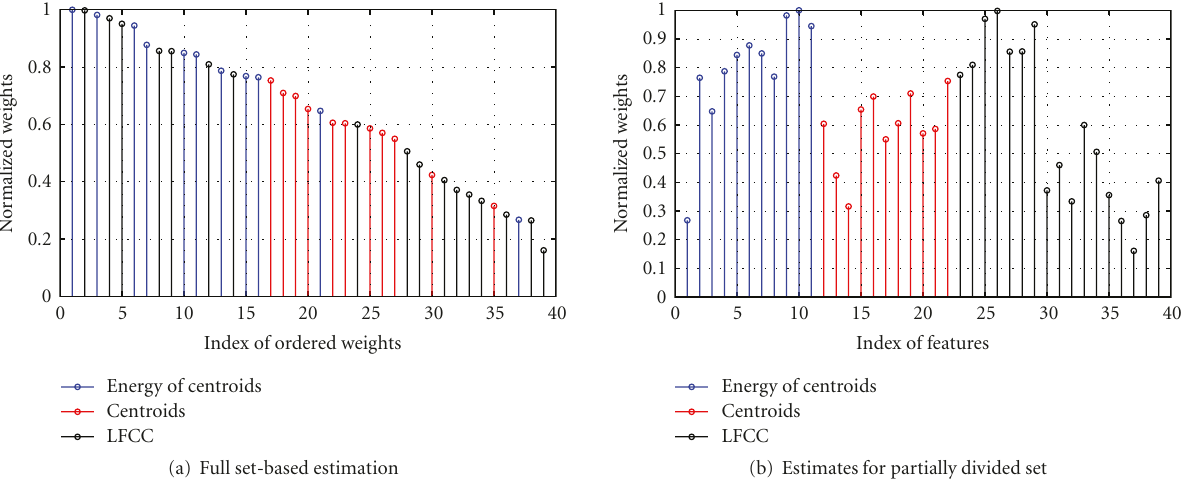
Figure 5: On computing relevance weights for considered combining approaches of comparison among dynamic features.